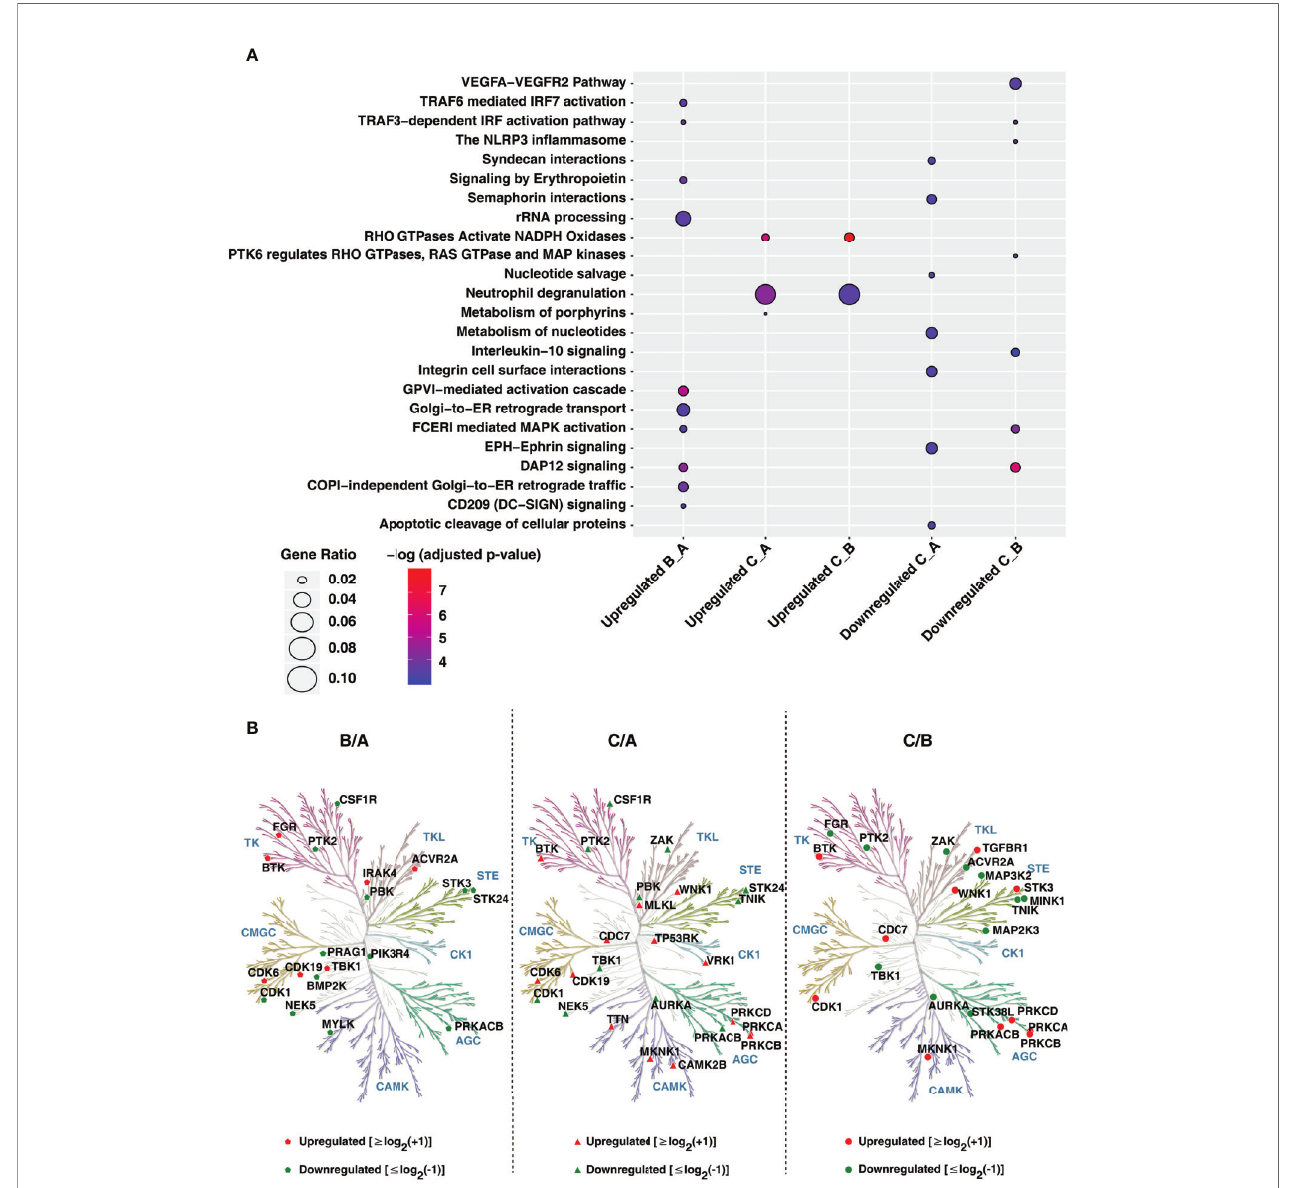
FIGURE 4 | Gene ontology analysis of proteins upon PMA induced monocyte to macrophage differentiation. (A) Gene Ontology analysis of upregulated and downregulated proteins in conditions A-C using ReactomePA. The X-axis represents proteins changing in Condition B with respect to A (B_A), Condition C with respect to A (C_A) and Condition C with respect to B (C_B). (B) Kinome trees showing differential regulation of protein kinases in response to differentiation conditions A-C. The phylogenetic kinase relationship (47) were generated using KinMap. Protein kinases identi fi ed and quanti fi ed in our study are indicated as red (upregulated) and green (downregulated) symbols (circles and triangles),